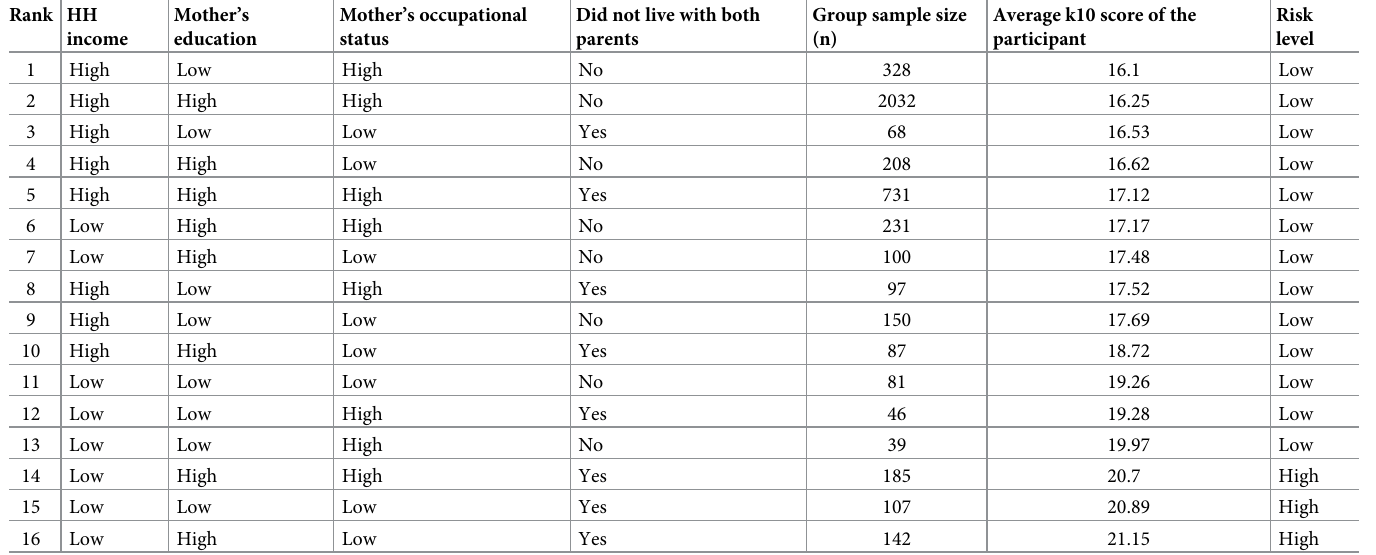
Table 2. Mental health opportunity